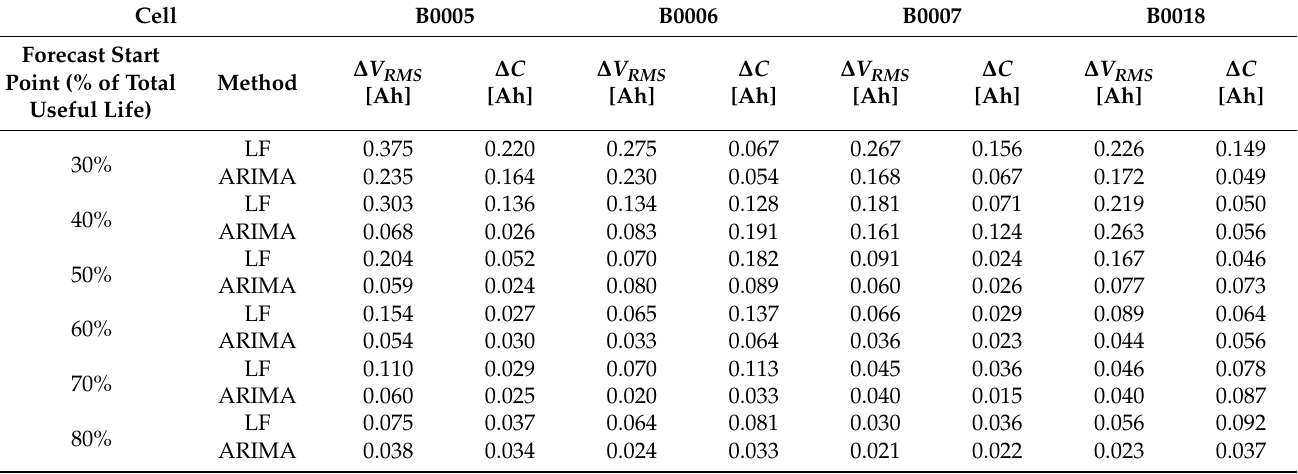
Figure 6. Raw and filtered values of the ∆ V RMS health indicator for the analyzed cells when dis- charged at a C-rate of 1. Table 3. Comparative RMSE results between the proposed health indicator ∆ V RMS and the capacity fade ∆ C with respect to the measured capacity fade ∆ C (objective time series) for each studied cell with a discharge current of 2 A (C-rate of